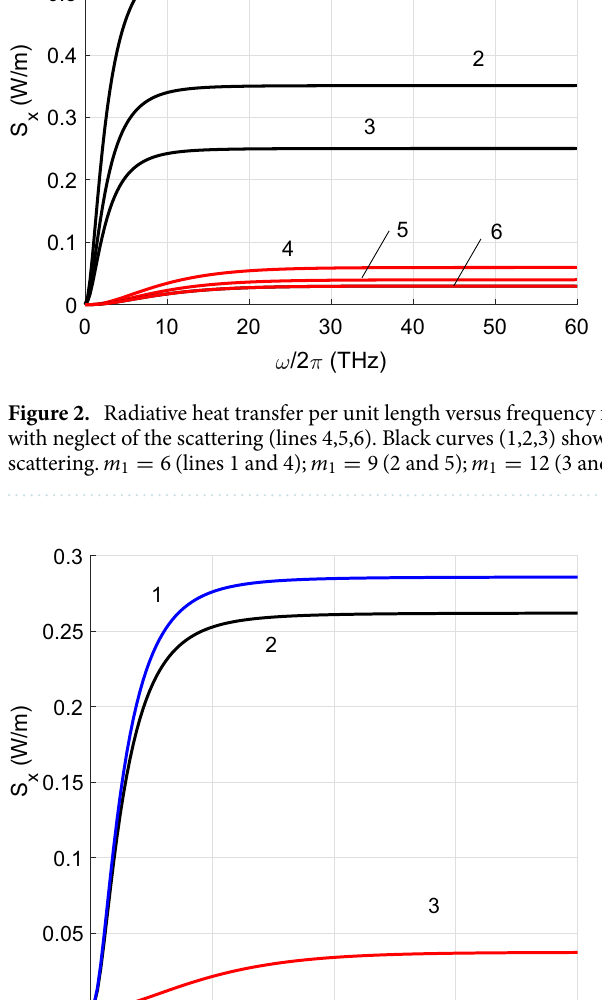
m 2 9 (black curve). The red curve is obtained = =